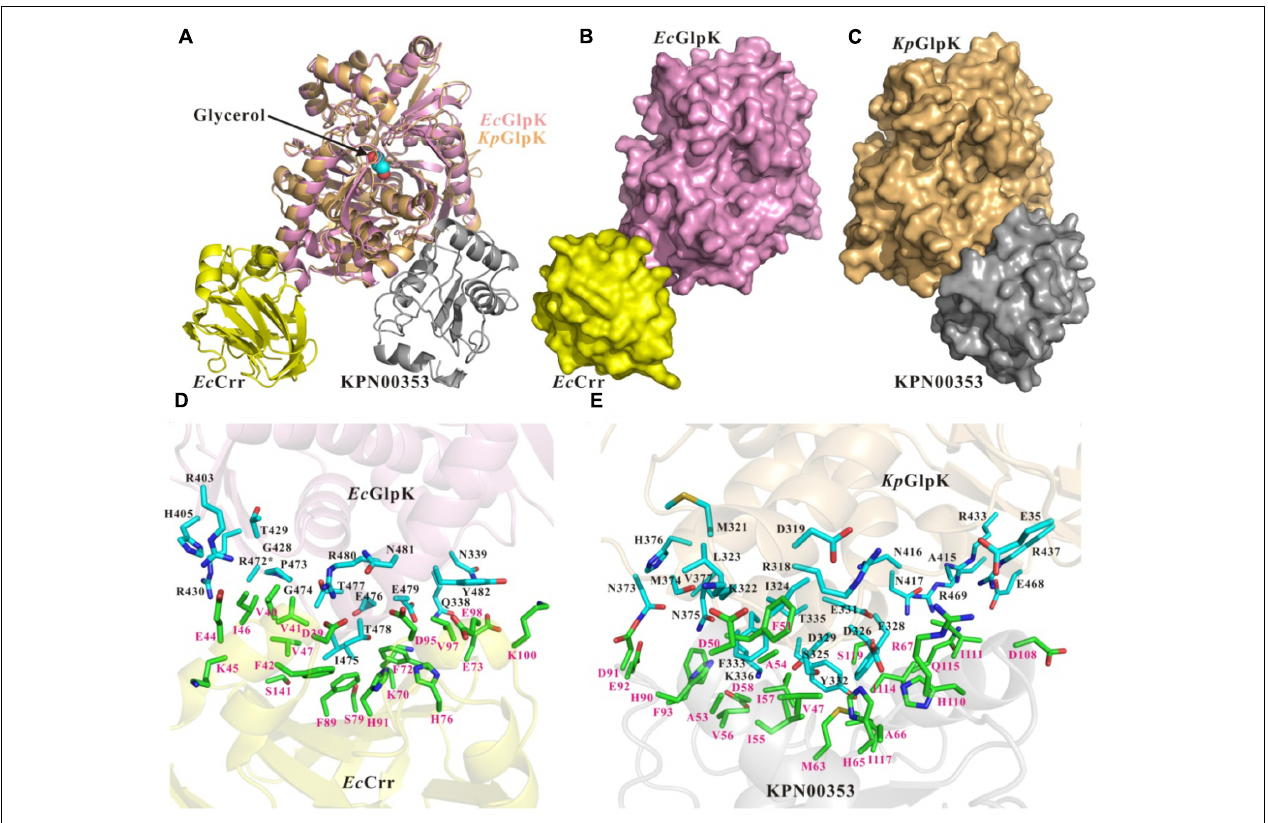
FIGURE 7 | Structures and interface residues of the E. coli GlpK-Crr complex and K. pneumoniae GlpK-KPN00353 complex. (A) Superposition of cartoon representations of E. coli GlpK-Crr complex (solved structure, PDB accession code 1GLA) and K. pneumoniae GlpK-KPN00353 complex (modeled structure). Surface representations of (B) the E. coli GlpK-Crr complex and (C) the K. pneumoniae GlpK-KPN00353 complex in the same orientation as in (A) . (D,E) Close-up view of the interfaces of the E. coli GlpK-Crr complex and the K. pneumoniae GlpK-KPN00353 complex, respectively. The E. coli GlpK, E. coli Crr, K. pneumoniae GlpK and KPN00353 molecules are shown in pink, yellow, light-orange and gray, respectively. The side chains of the interface residues of GlpK molecules are shown in cyan (carbon atoms) stick models and labeled in black. The side chains of the interface residues of the Crr and KPN00353 molecules are shown in green (carbon atoms) stick models and labeled in magenta. The glycerol molecule is shown in a spheres model. Oxygen atoms are shown in red and nitrogen atoms in blue. ∗ The R472 side-chain atoms of E. coli GlpK are missing atoms in the 1GLA coordination